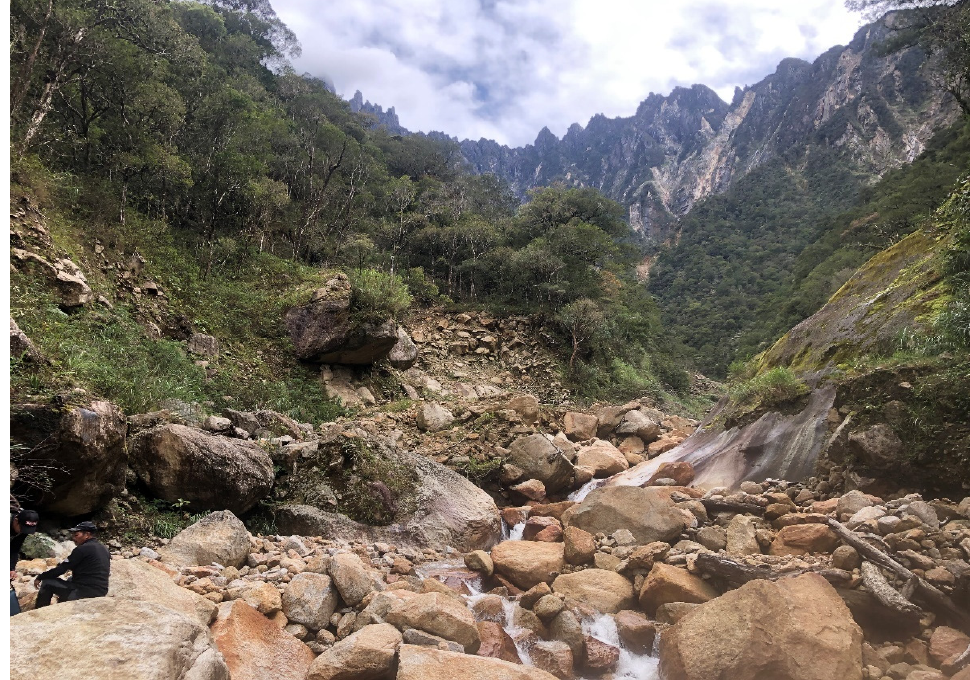
Figure 2. The evidence of boulders accumulated in the channelised Mesilau river after the debris flow event.